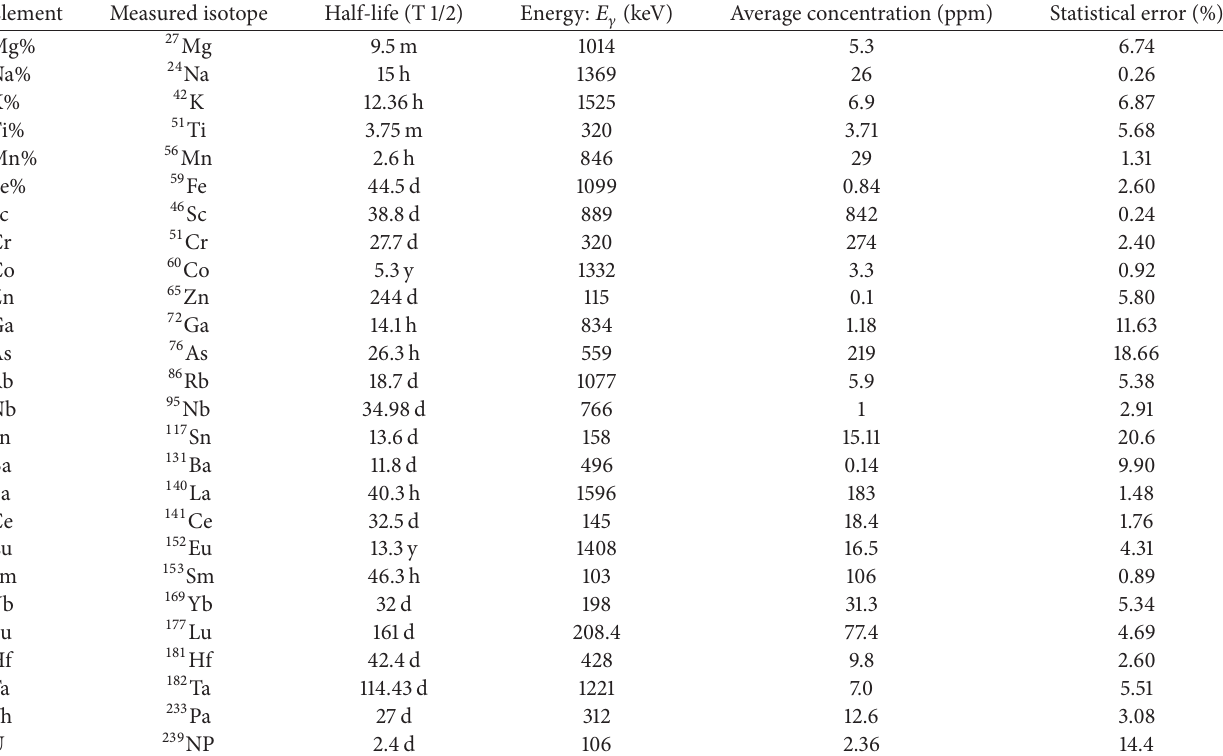
Table 2: Clay composition and the average concentration of the elements calculated using INAA. Element Measured isotope